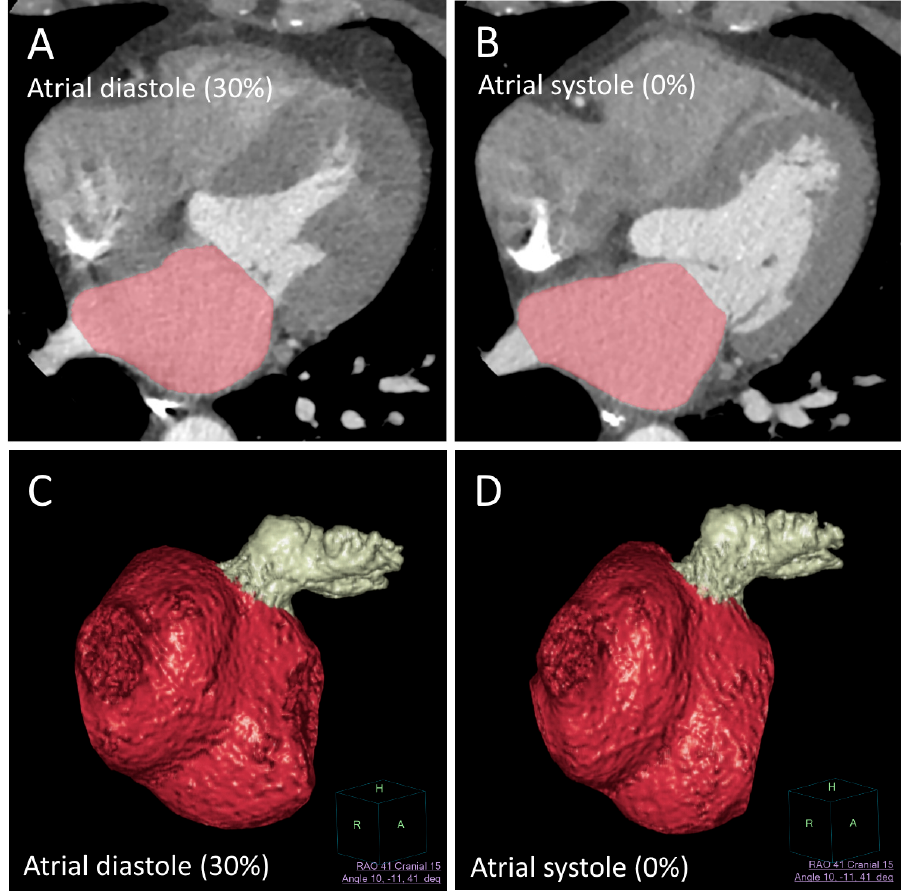
Figure 1. Automatic left atrial segmentation (red) as proposed by Wolf et al. [20] (electrophysiology/EP planning tool, Intellispace Portal, Philips, Best, The Netherlands) with additional manual segmentation of the left atrial appendage (LAA) (white). ( A ) and ( B ) demonstrate the automatic segmentation of the left atrium (LA) in atrial systole and diastole. ( C ) and ( D ) demonstrate the 3D surface rendering of the LA and LAA in systole and diastole.